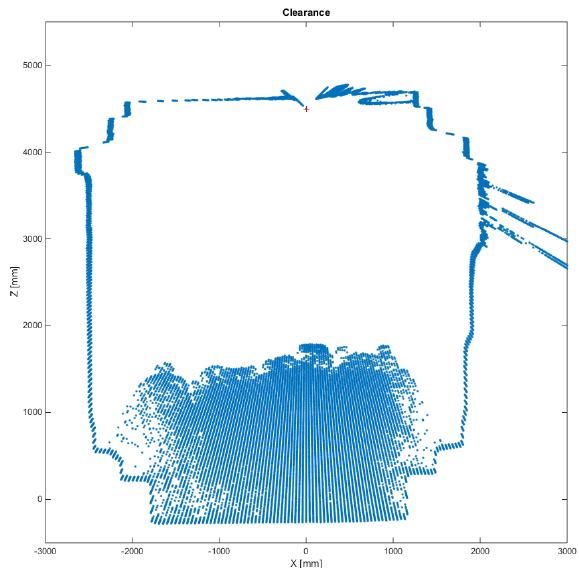
Figure 3. Clearance diagram for the corridor. (The scanner is marked by red